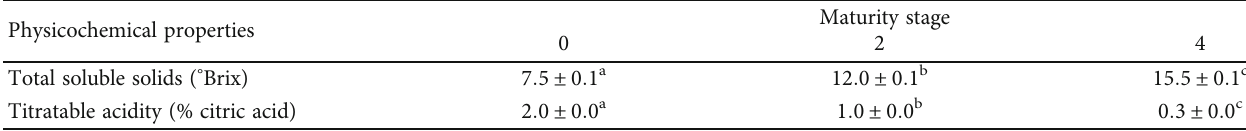
Table 1: Soluble solids and acidity of mango according to maturity